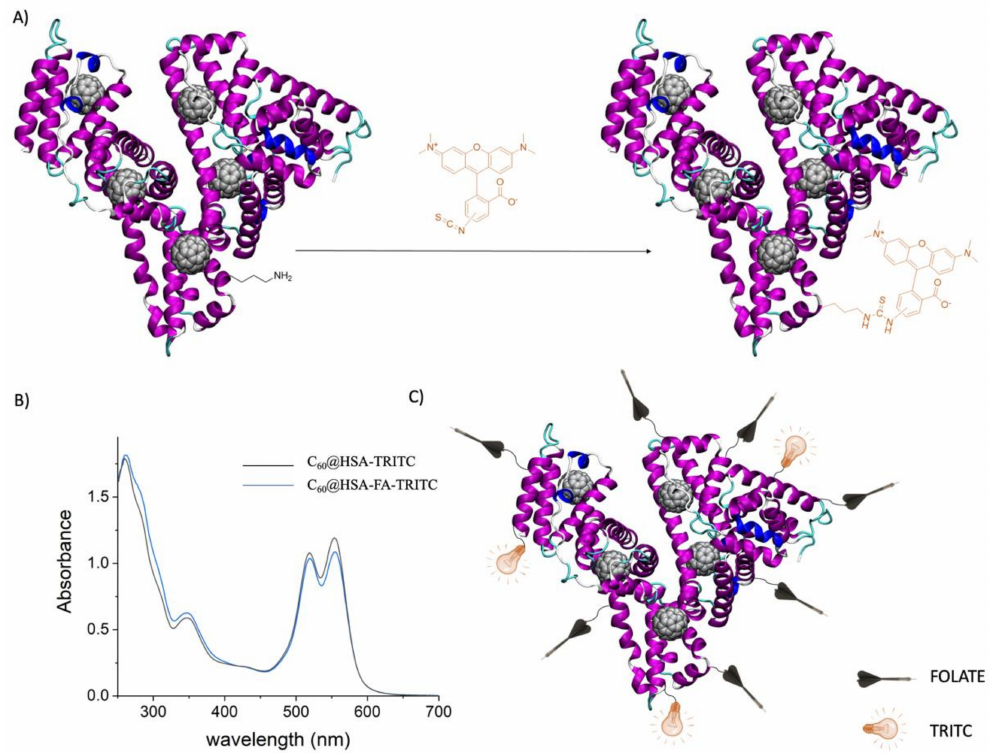
Figure 4. ( A ) Bioconjugation of TRITC to C 60 @HSA/C 60 @HSA-FA. ( B ) UV–visible spectra of C 60 @HSA-TRITC (black line) and C 60 @HSA-FA-TRITC (blue line) in PBS. In Figure S11, the UV– visible spectrum of TRITC in PBS. ( C ) Creation of an C 60 @HSA-based theranostic platform by protein conjugation of the targeting agents (FA) and imaging tags